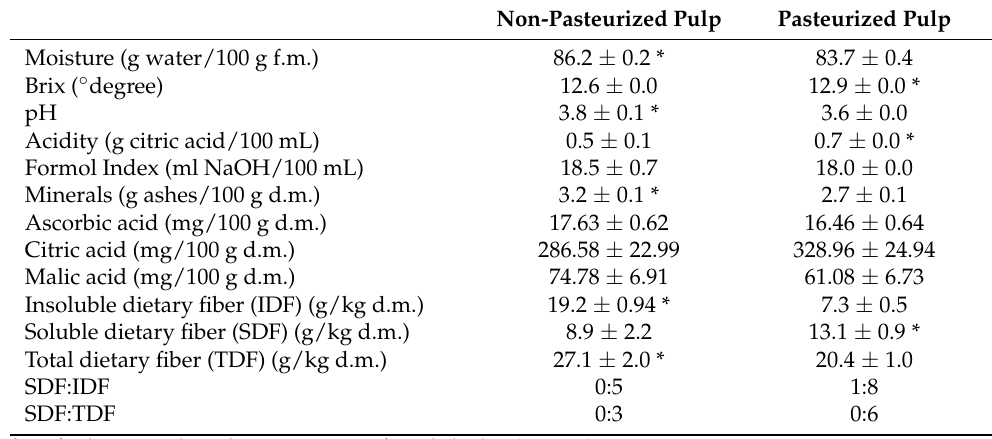
Table 2. Macro- and microelements of non-pasteurized (NPP) and pasteurized orange pulp (PP) by-products. Non-Pasteurized Pulp Pasteurized Pulp Macroelements